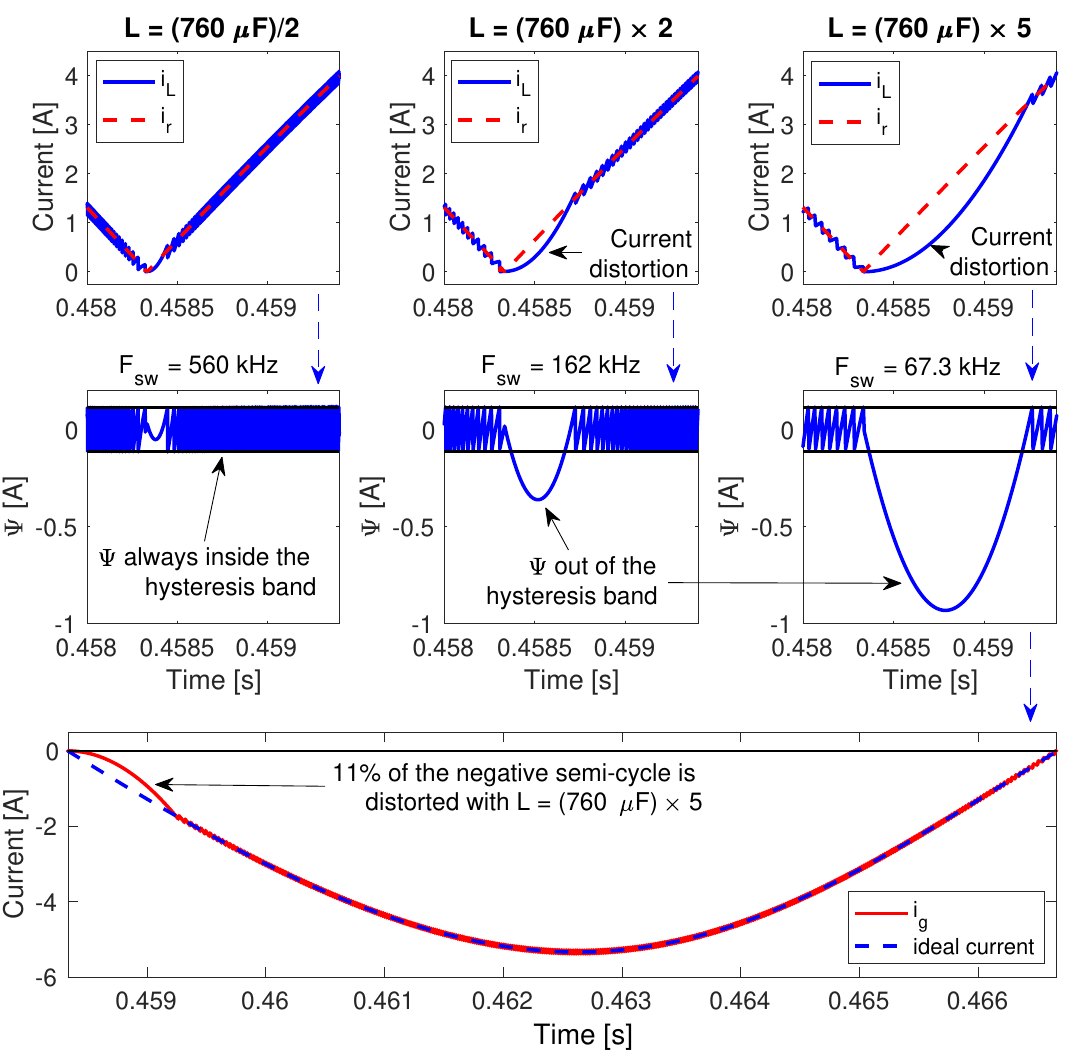
Figure 16. Effects of violating the L and ∆Ψ